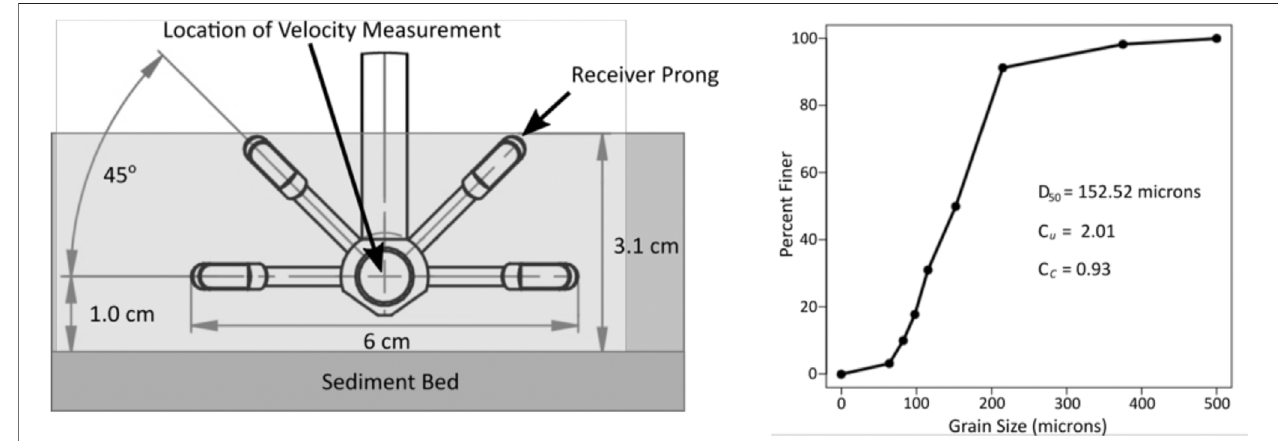
FIGURE 3 | Schematic side view of ADV sensor head placement relative to the initial sediment bed (left panel). Cumulative grain size distribution of the sediment used to build the dunes in the sediment wave fl ume (right panel). D 50 is the median grain size, C u is the coef fi cient of uniformity, and C c is the coef fi cient of curvature.